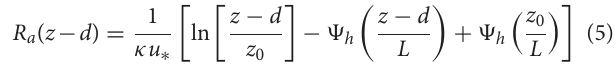
40 m height interval and K , the turbulent diffusivity, which